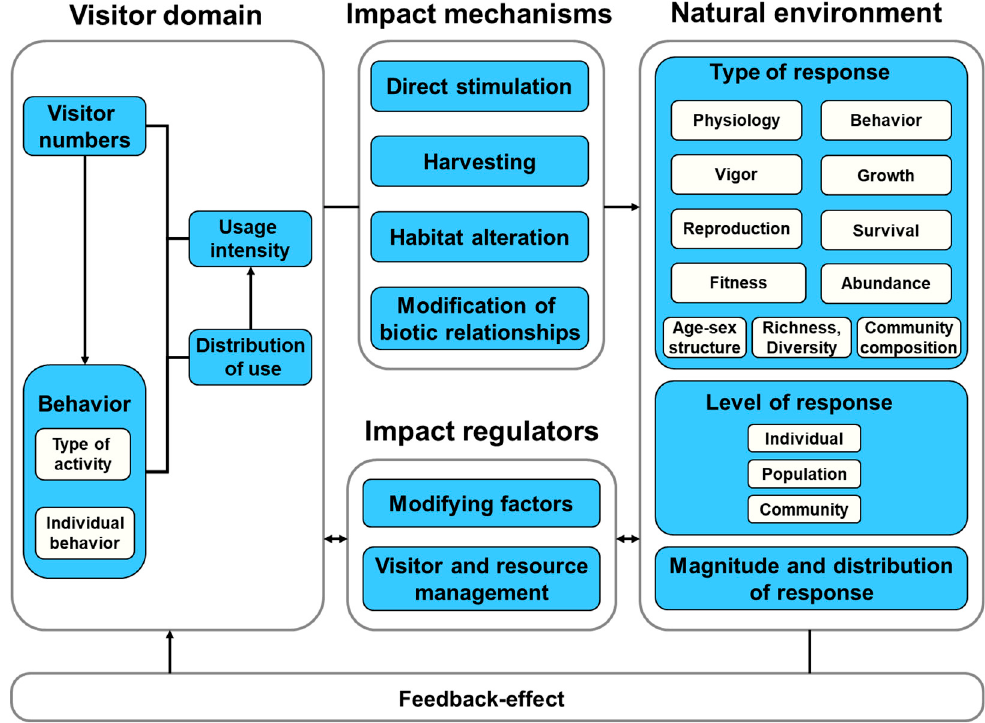
Figure 1. A conceptual framework of the relationship between visitors who engage in nature-based tourism activities and the natural environment.